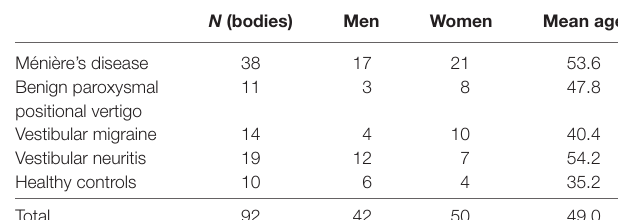
Table 1 | age and gender in each